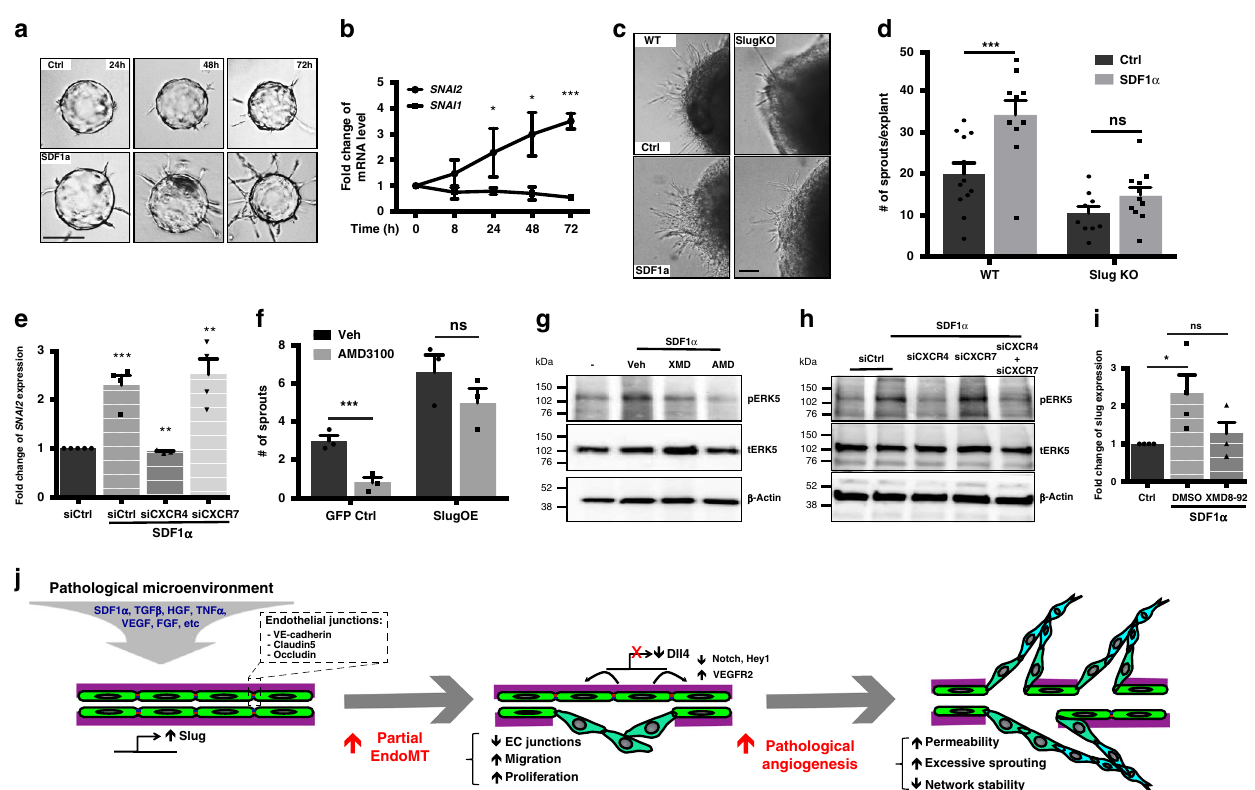
Fig. 7 Slug is an SDF1 α downstream effector during angiogenesis. a SDF1 α treatment leads to early and increased tip cell formation and sprouting in the fi brin-gel bead assay. Scale bar: 100 µ m. b SDF1 α treatment leads to activation of Snai2 but not Snai1 transcription ( n ≥ 3 cell lines per condition, see source data for detail. 24 h p = 0.04, 48 h p = 0.012, and 72 h p = 0.003). c SDF1 α induces increased sprouting in WT ( p = 0.003) but not SlugKO mouse retina explants. Scale bar: 100 µ m. d Quanti fi cation of the number of sprouts per retina explant (WT-Ctrl n = 12 animals, WT-SDF1 α n = 10 animals, SlugKO-Ctrl n = 9 animals, SlugKO-SDF1 α n = 11 animals). e qPCR analysis of Slug induction by SDF1 α in EC treated with siCtrl ( n = 4 cell lines, p = 0.0002), siCXCR4 ( n = 3 cell lines, p = 0.004), or siCXCR7 ( n = 4 cell lines, p = 0.001). f Slug overexpression in EC rescues AMD3100 inhibition of sprouting. ( n = 3 cell lines for all conditions, p = 0.0057). g SDF1 α activation of ERK5 phosphorylation and blocking by inhibition of ERK5 (XMD8-92) or CXCR4 (AMD3100). h ERK5 phosphorylation downstream of SDF1 α is abolished by CXCR4 knockdown but not CXCR7 knockdown. i SDF1 α induction of Slug ( p = 0.0037) is blocked by the ERK5 inhibitor XMD8-92 ( n = 4 cell lines for all conditions). j Model for Slug-mediated pathological angiogenesis. Data represent mean